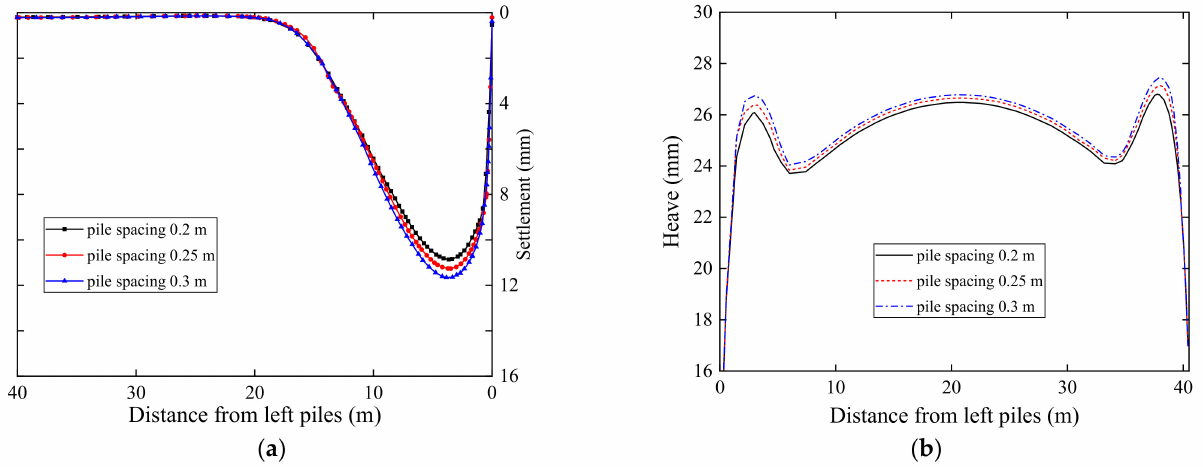
Figure 20. Settlement curve of surface soil and uplift curve of the bottom of excavation: ( a ) surface settlement curve; ( b ) heave